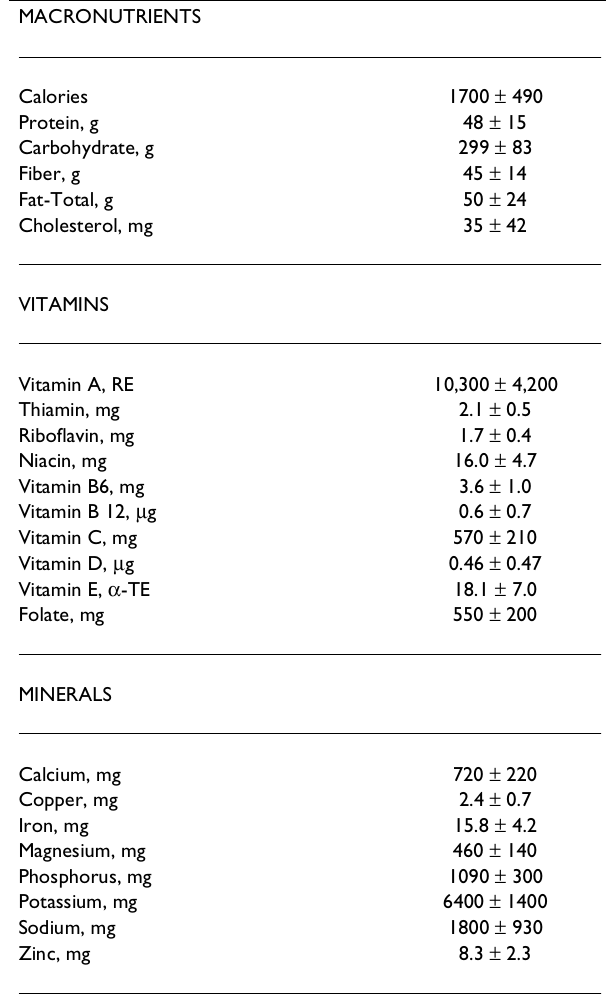
Table 1: Nutrient Intake of Subjects. N =